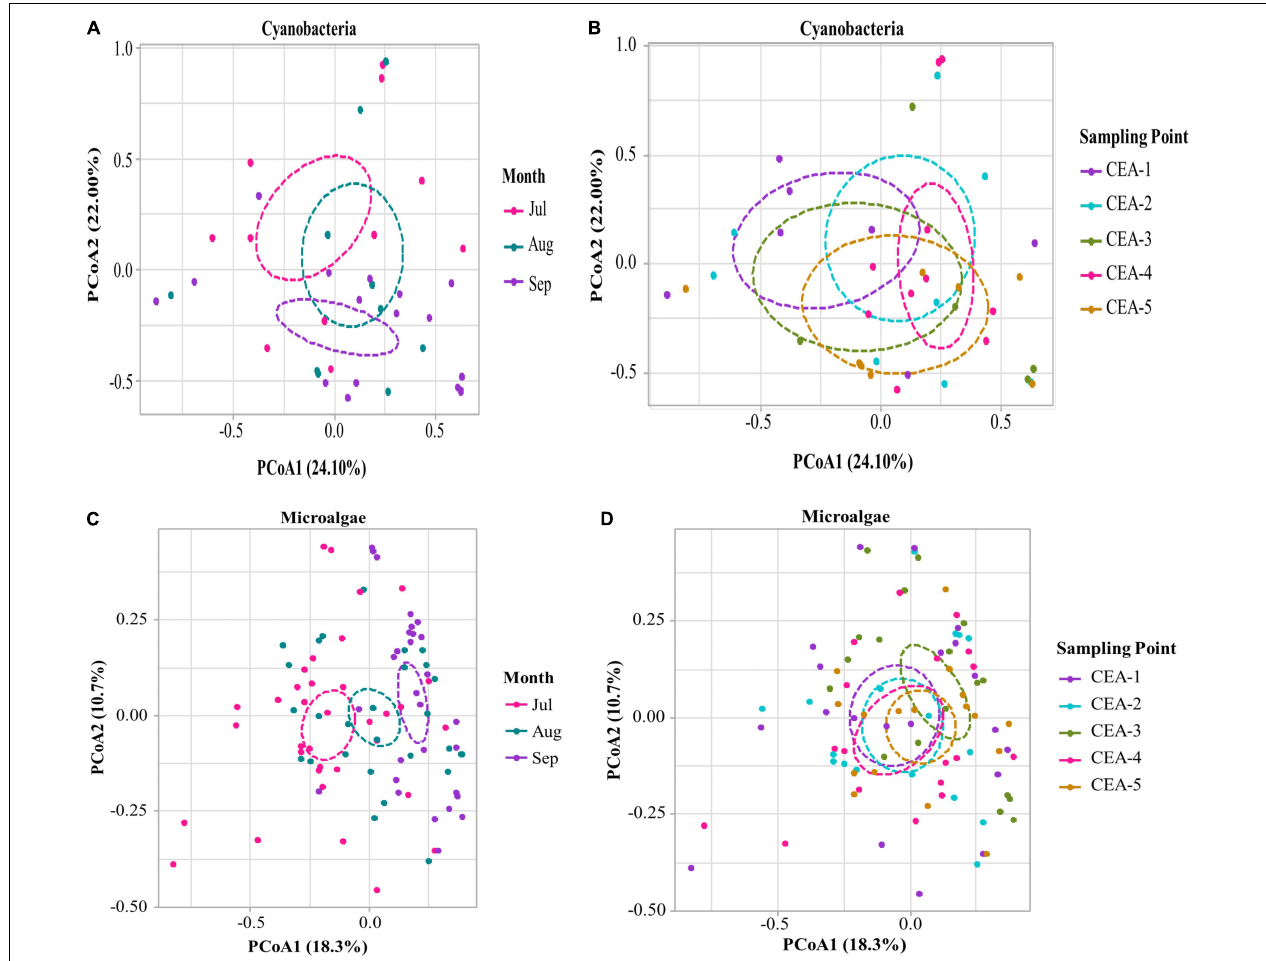
FIGURE 7 | Principal coordinates analysis (PCoA) of the dissimilarities among microbial communities by month and sampling point using the Bray-Curtis distances. (A) PCoA of cyanobacterial communities by sampling month. (B) PCoA of cyanobacterial communities by sampling point. (C) PCoA of microalgae communities by sampling month. (D) PCoA of microalgae communities by sampling